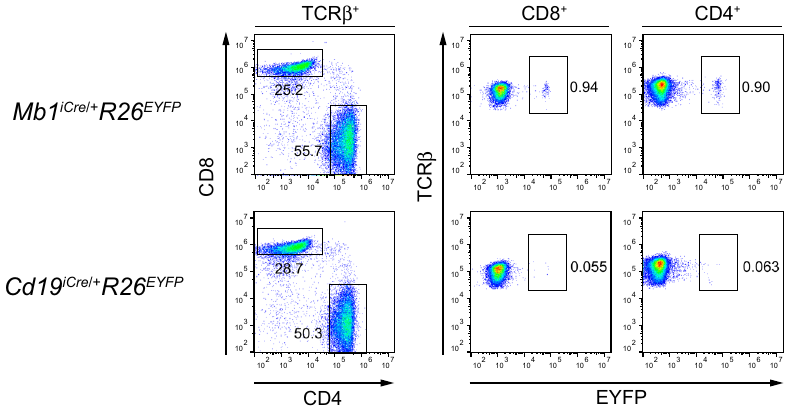
Figure 3. Cre-mediated recombination in T cells is not observed in CD19-iCre/Rosa26-EYFP double transgenic mice. EYFP expression is demonstrated in splenic TCRβ + CD4 + and TCRβ + CD8 + T cells of Mb1 iCre /+ R26 EYFP and Cd19 iCre /+ R26 EYFP mice. Data are representative of two independent experiments.